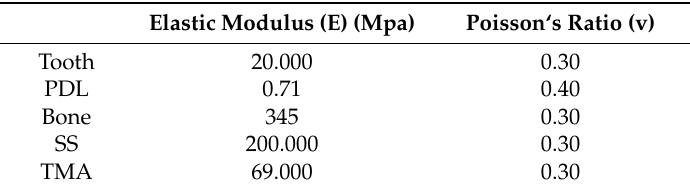
Table 1. Properties of anatomic structures and material tested. PDL = periodontal ligaments, SS = stainless steel.